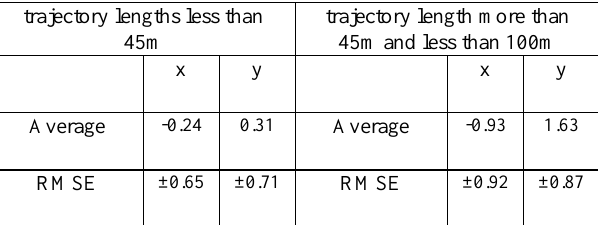
Table 1. Quantitative assessment of layout structural control points (unit: pixel).